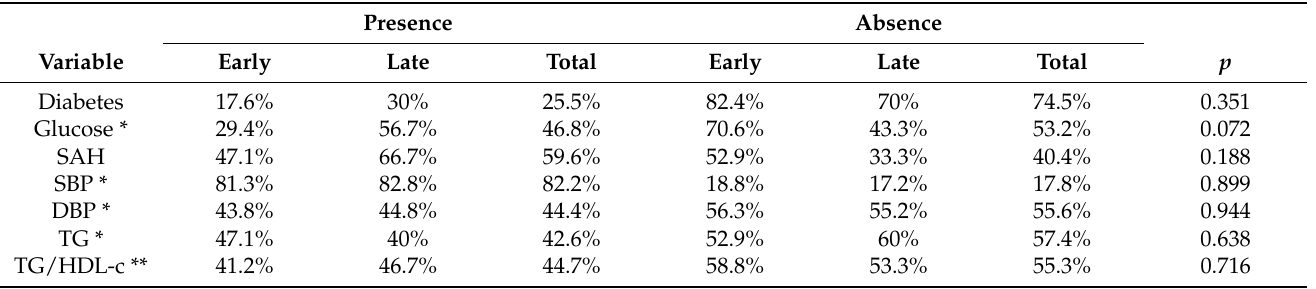
Table 3. Association of the presence or absence of alterations related to MetS parameters with the life stage at obesity